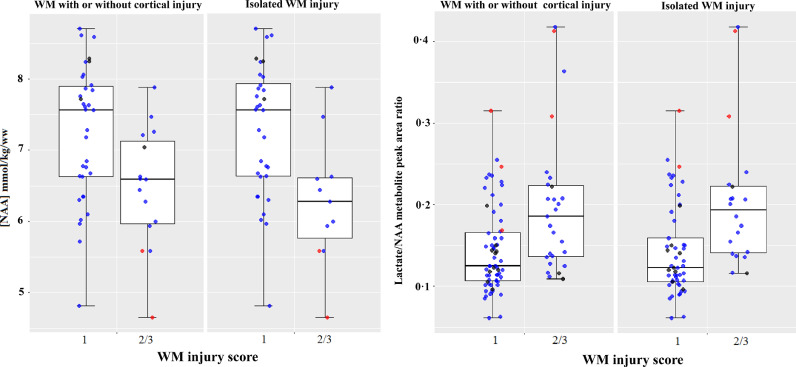
Boxplots of proton thalamic MRS [NAA] and Lactate/NAA values for neonates with WM injury with or without cortical injury compared to those with isolated MRI WM injury. The boxplots exhibit the spread of data points across the median and IQR for each injury score group. Medians are represented by horizontal lines; the boxes represent the upper and lower quartiles; and the whiskers indicate 1.5xIQR from upper and lower quartiles. Blue dots indicate normal outcome, red dots are patients with adverse outcomes, and the black dots are those with unknown outcomes.